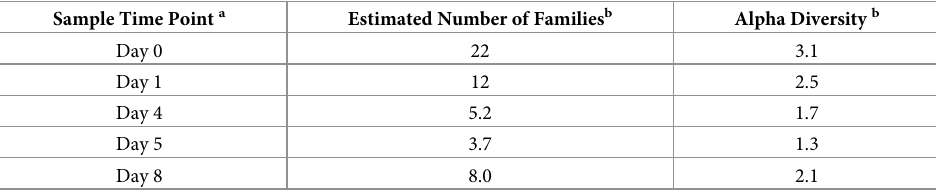
Table 1. Estimated number of families and alpha diversity of the soil enrichment